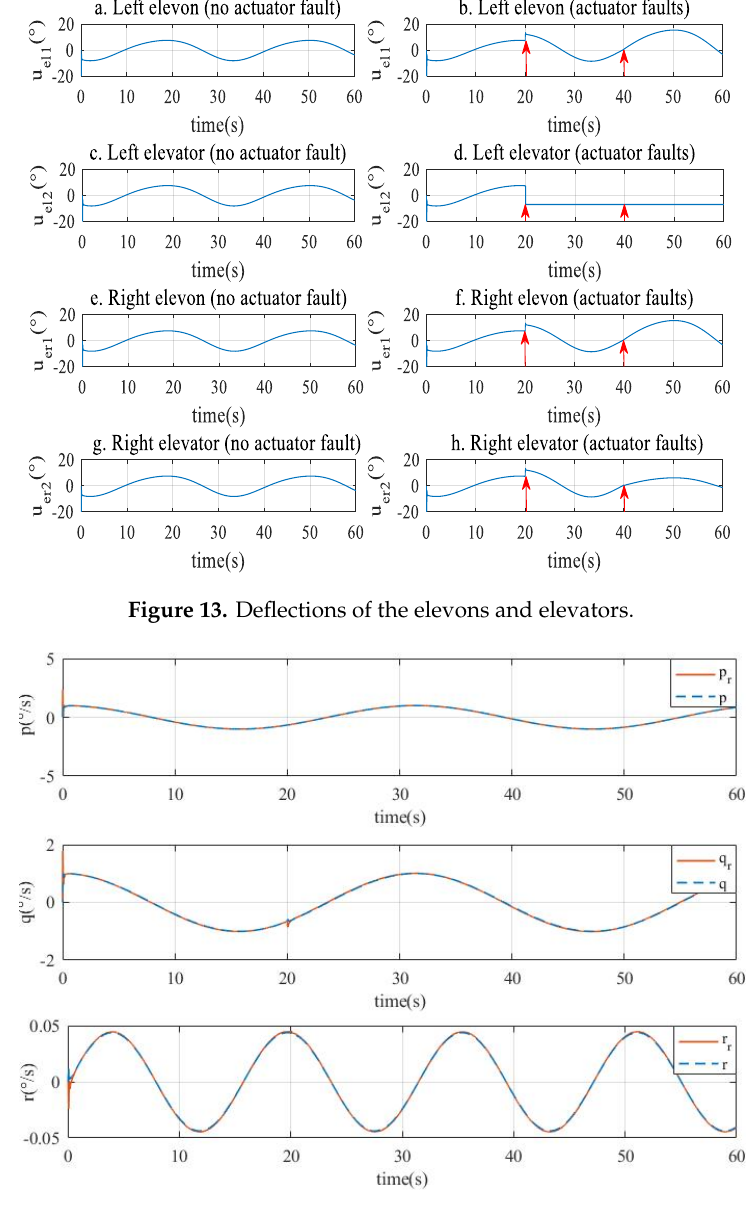
Figure 14. Angular rate tracking with actuator faults.